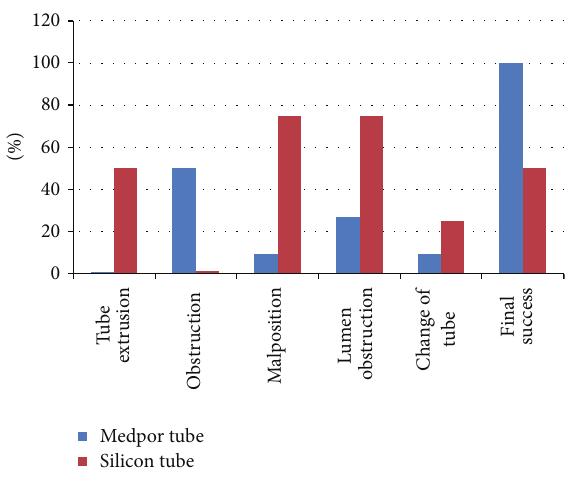
Figure 4: Postoperative complication rates and final success rates of both